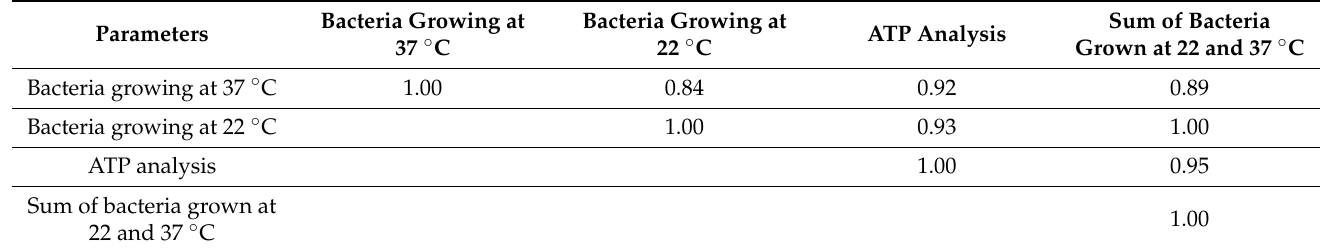
Table 3. Summary of the results of the fractographic examination of profile lines.